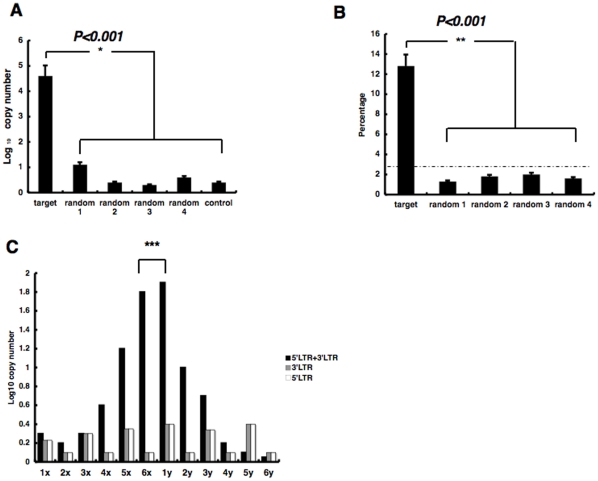

In vitro integration efficiency and selectivity.(A) Copy number of PCR products with using primers for the HIV-1 LTR and substrate DNA following integration into the target sequence or random sequences in the substrate DNA, referred to as post-integration amplified products (PIAP). The vertical axis represents log PIAP. Error bars indicate standard deviation (S.E.) (*P<0.001). Plasmid DNA lacking the target sequence was used as a control. (B) Percentages of PIAP copies from the integration into the target sequence or random sequences vs. the total number of PIAP. Dotted line shows the ratio when integration was thought to occur uniformly in the 4-kb substrate DNA. Error bars represent standard deviation (S.E.) (**P<0.001). (C) Number of PIAP copies from integrations into individual segments in x6y6. Vertical axis indicates log PIAP copy number. Error bars represent standard deviation (S.E.) (***P<0.001, 6x&1y vs. other segments).